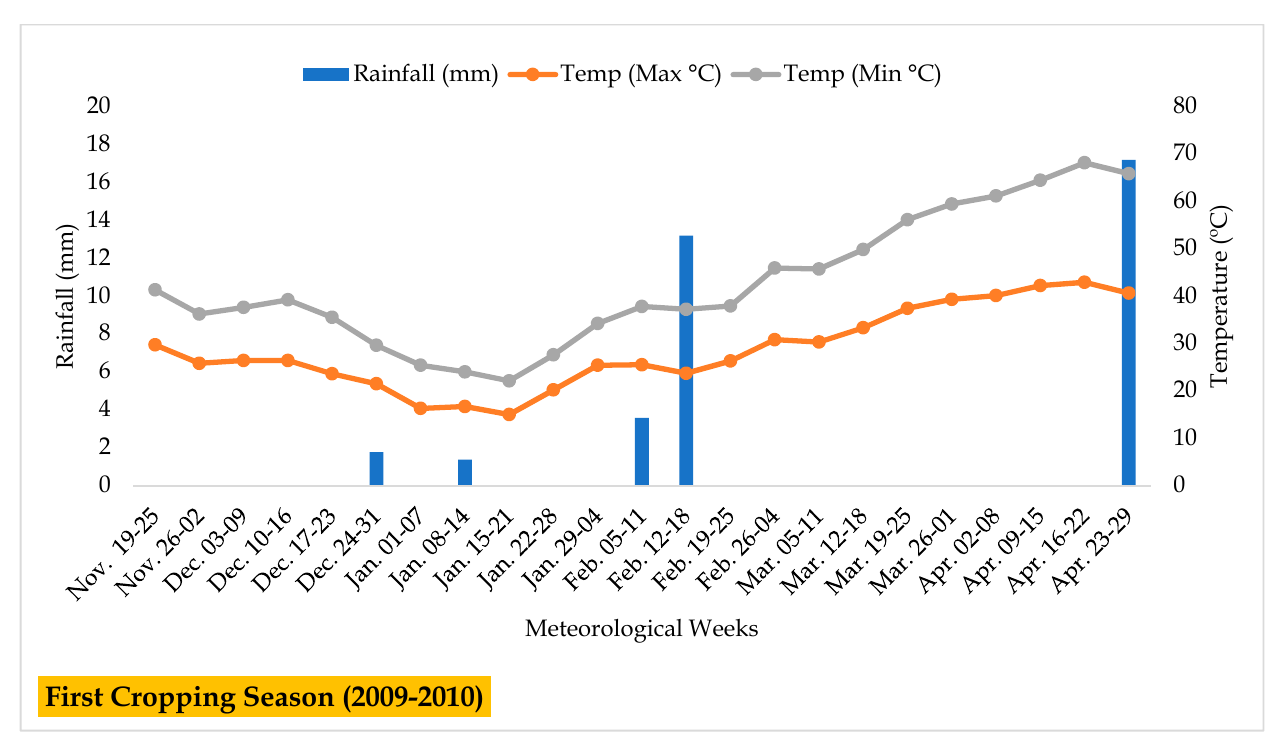
Figure 2. Climatic conditions during the first cropping season (Rabi 2009–2010).